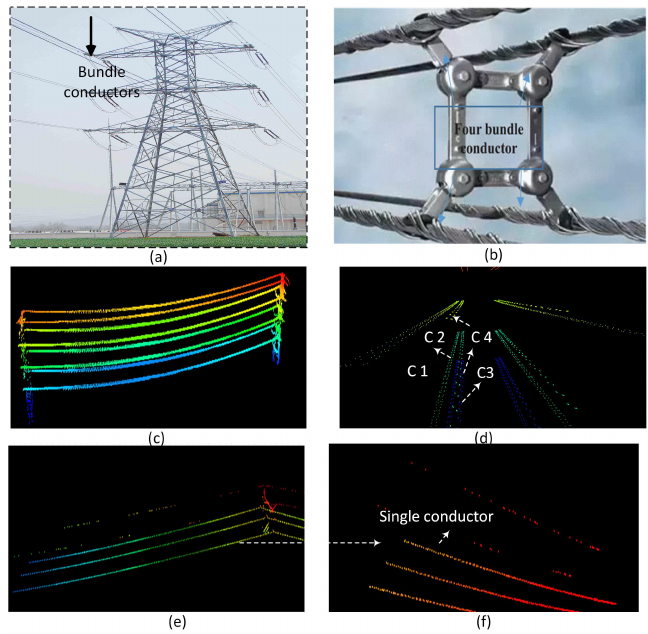
Figure 4. Data Collecting Methods Using LiDAR. Figure 4. Sub-conductors configuration. ( a ) high-voltage transmission line tower with bundles in sub-conductors configuration; ( b ) magnified version of bundle from ( a ); ( c ) LiDAR data for span with bundles in four sub-conductors configuration; ( d ) magnified version of bundle from ( c ); ( e ) LiDAR data for span with single power line; ( f ) magnified version of bundle from ( e